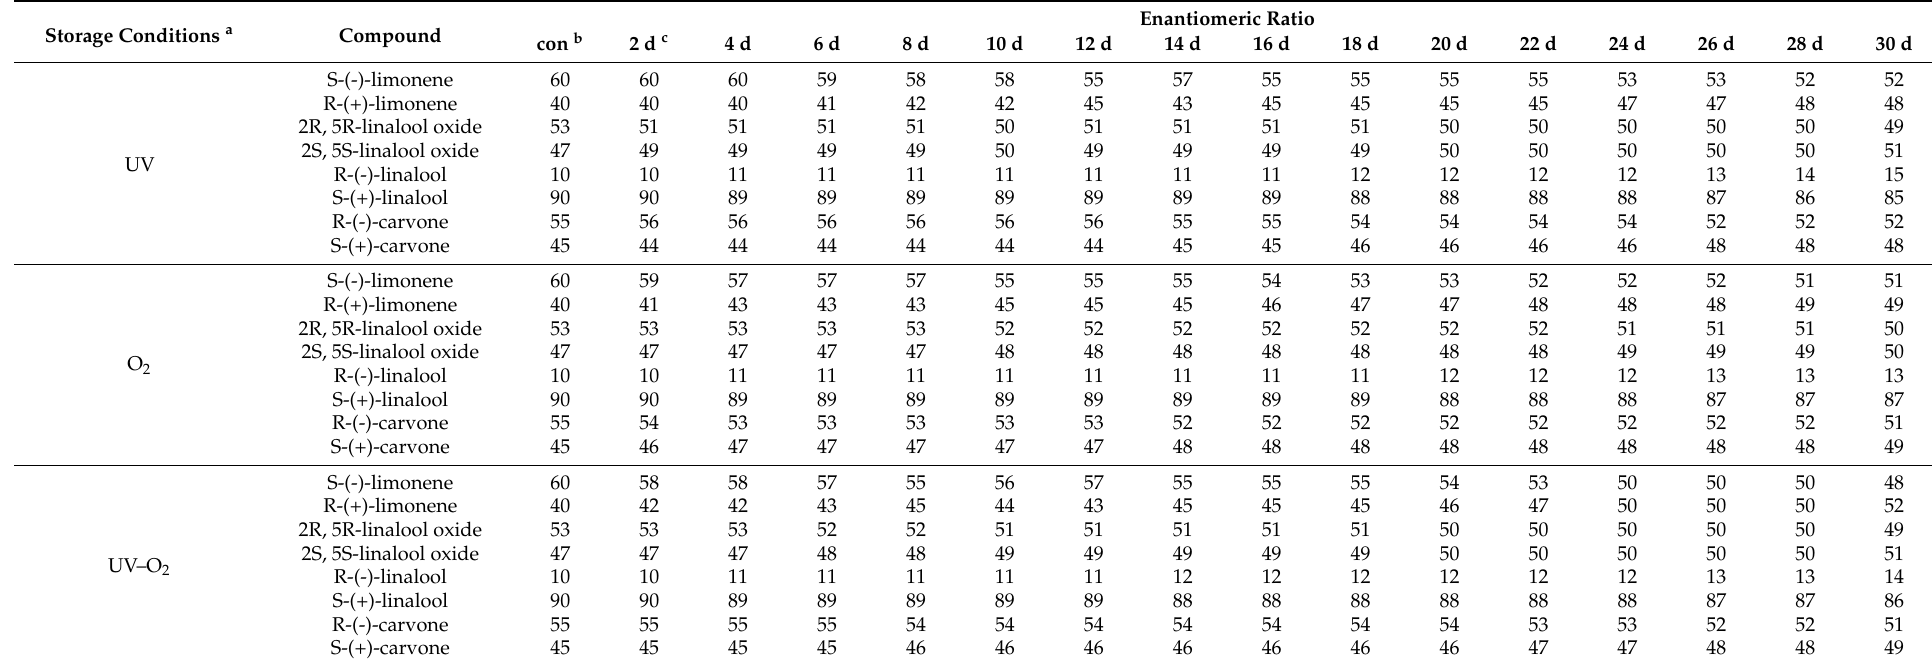
Table 2. Enantiomer ratio of chiral compounds in pepper oil under different storage